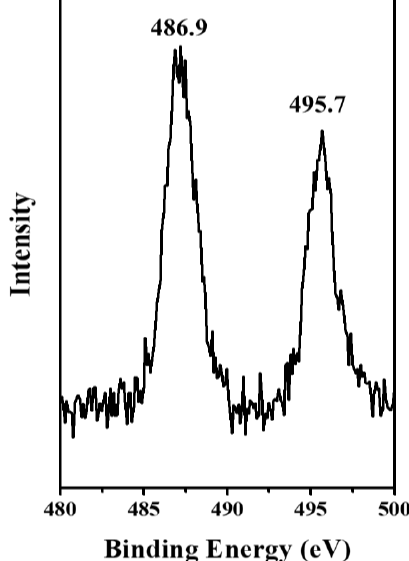
Figure 6. Sn 3d 5/2 and 3d 3/2 spectrum of the Sn-JHP-2.